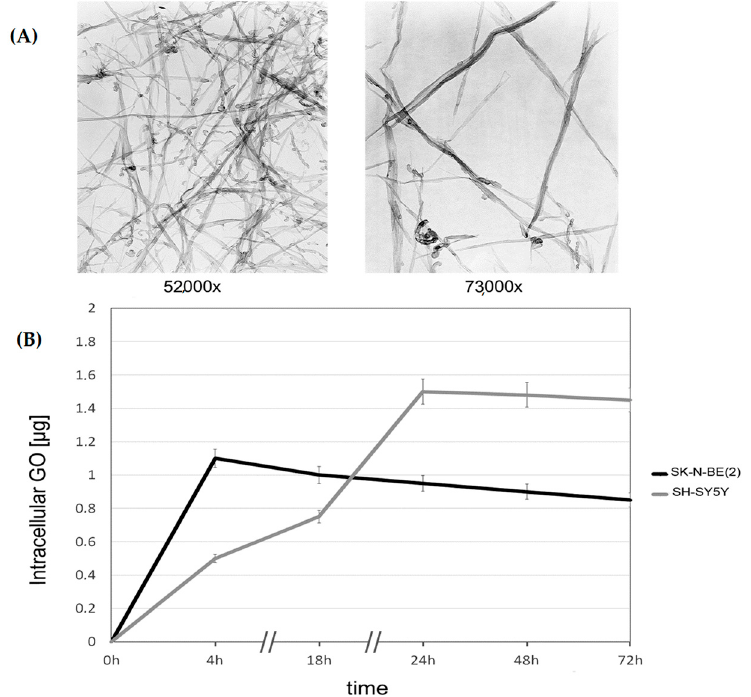
Figure 1. Uptake of graphene oxide (GO) nanoparticles: ( A ) characterization of nanoribbons by Transmission Electron Microscopy (TEM) ( left: 52,000× magnification; right: 73,000× magnification); and ( B ) uptake of GO nanoparticles in SK-N-BE(2) and SH-SY5Y cells in 72 h. Data are obtained from spectophotometer readings (OD 340) of supernatants at different times. Concentrations of GO were obtained by subtracting amounts present in supernatants from an initial (T0) concentration of 2 μg/mL.